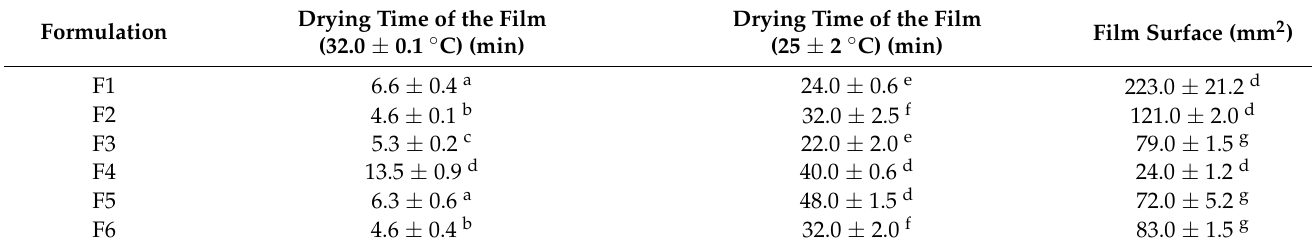
Table 3. Evaluation of the selected in situ film-forming formulations (mean ± SD, n = 3).